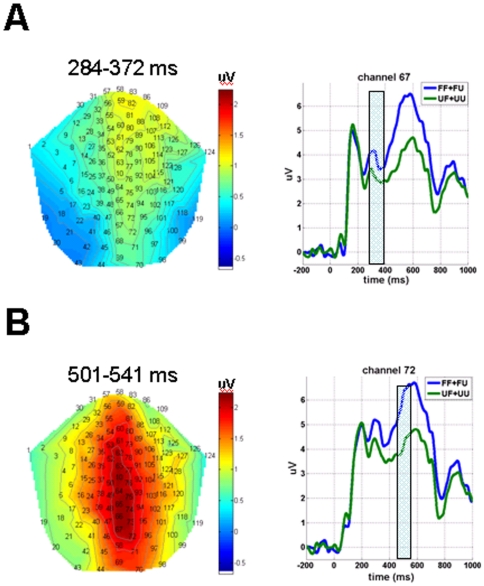
ERP waveforms at representative channels indicating the main effect of the identification of facial familiarity.Familiar faces elicited significantly more positive-going amplitudes than unfamiliar faces at two time windows: (A) From 284 to 372 ms (N400f) post stimulus in the middle parietal (represented by channel 67) and right parietal regions; (B) From 501 to 541 ms (P600f) post-stimulus in the middle parietal (represented by channel 72) and occipital regions. The shadowed bars cover the time windows indicated above. Fam = familiar faces, Unfam = unfamiliar faces, “Fam” = responded as familiar faces, and “Unfam” = responded as unfamiliar faces.